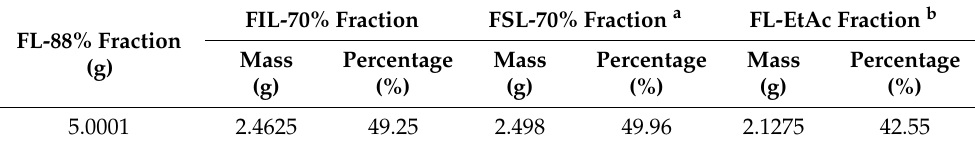
Table 1. Mass balances of FL-88%, FIL-70%, FSL-70%, and FL-EtAc lignin